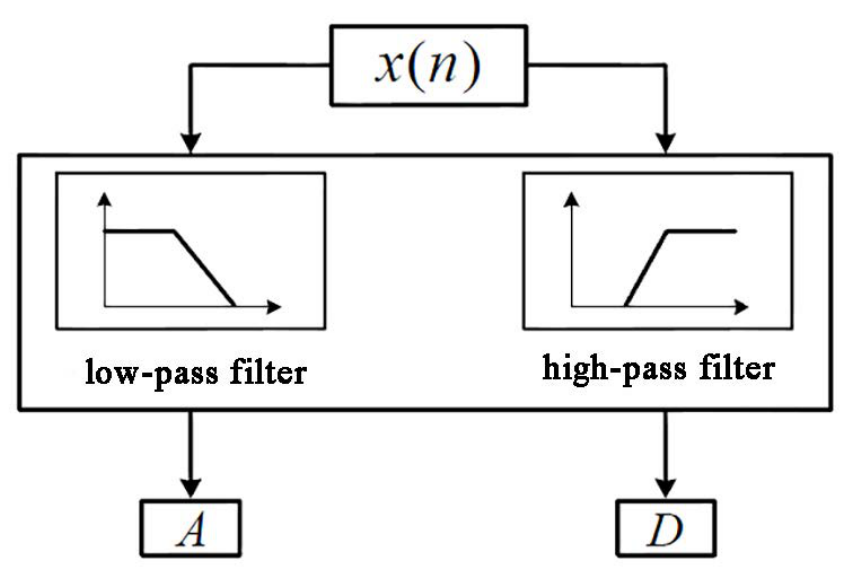
Figure 4. Diagram of the wavelet filtering pro-cessing module.